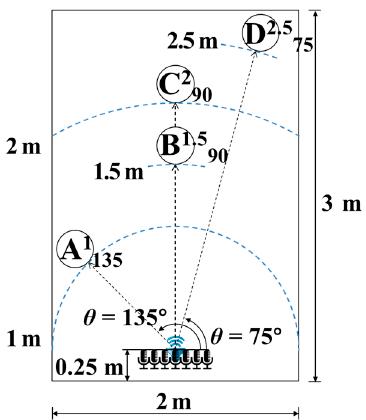
Figure 7. Experimental configuration for the verification of the proposed approach in terms of localization performance using a polyvinyl chloride (PVC) pipe or a human intruder in an anechoic chamber or a classroom. A, B, C, and D are the positions of the silent intruder. The superscripts represent the distance and the subscripts describe the angle (measured counterclockwise) between the microphone array and the intruder.